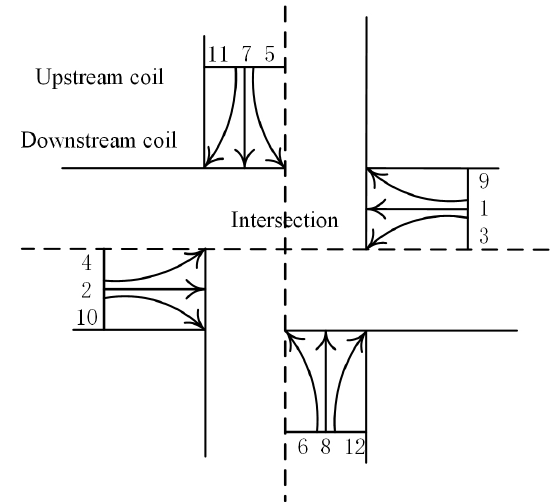
Figure 1. The geometric description of a four-phase